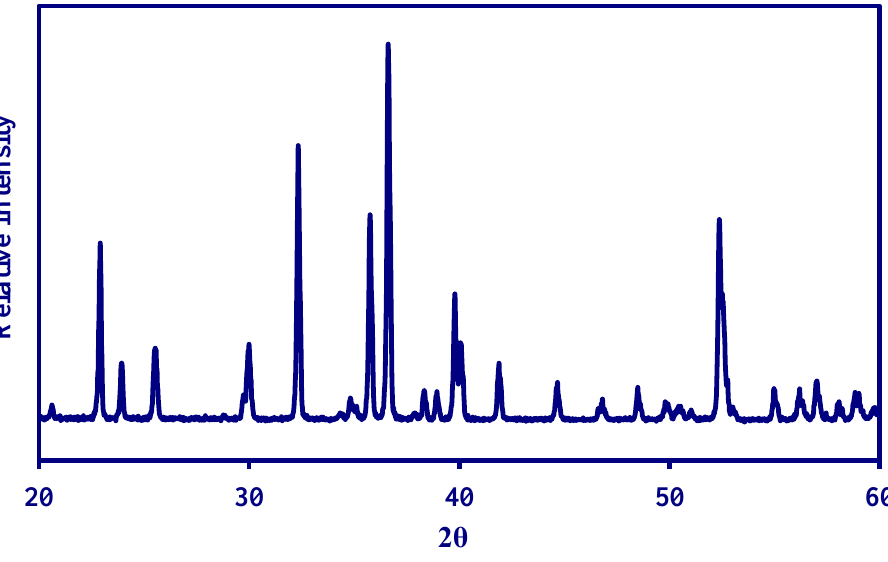
Figure 1. XRD profile of magnesium nickel silicate (MNS)